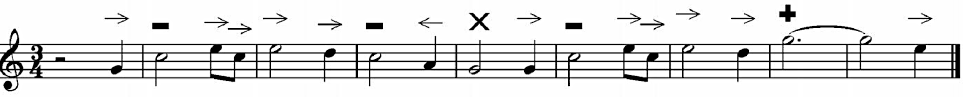
Figure 4. A screenshot of the performance worm. The x-axis shows the tempo in beats per minute; the y-axis shows the loudness in decibels [29].